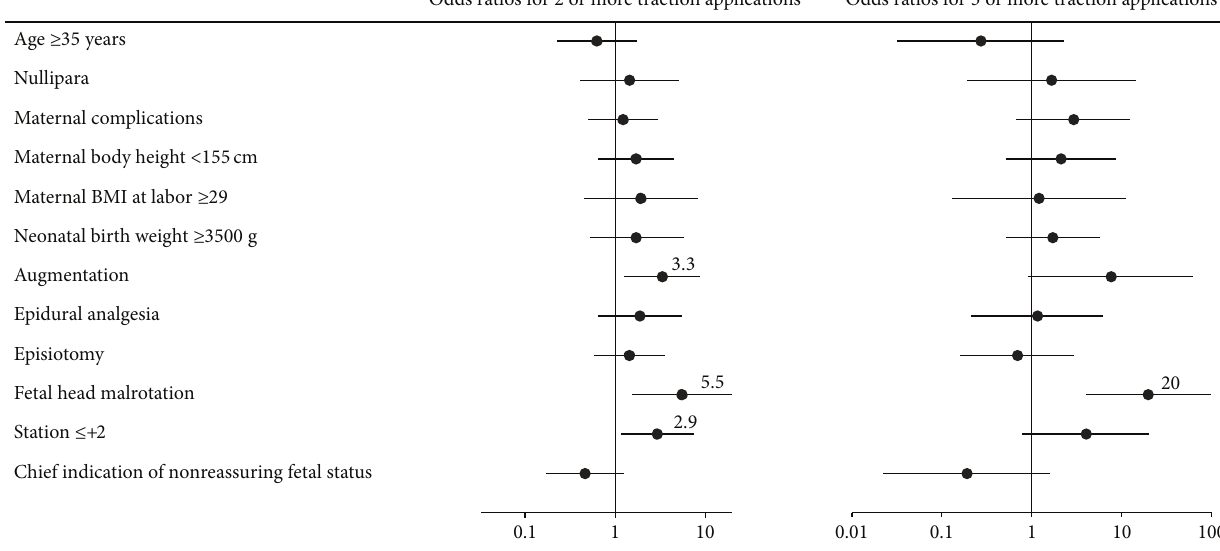
Figure 2: Crude odds ratios for two or more and three or more traction applications. Horizontal bars indicate 95% confidence intervals. BMI: body mass